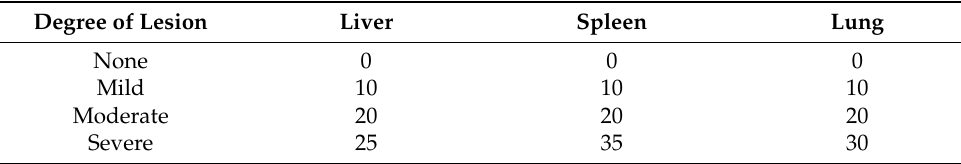
Table 2. Criterion for the gross pathological score of the liver, spleen and lung. Degree of Lesion Liver Spleen Lung None 0 Moderate